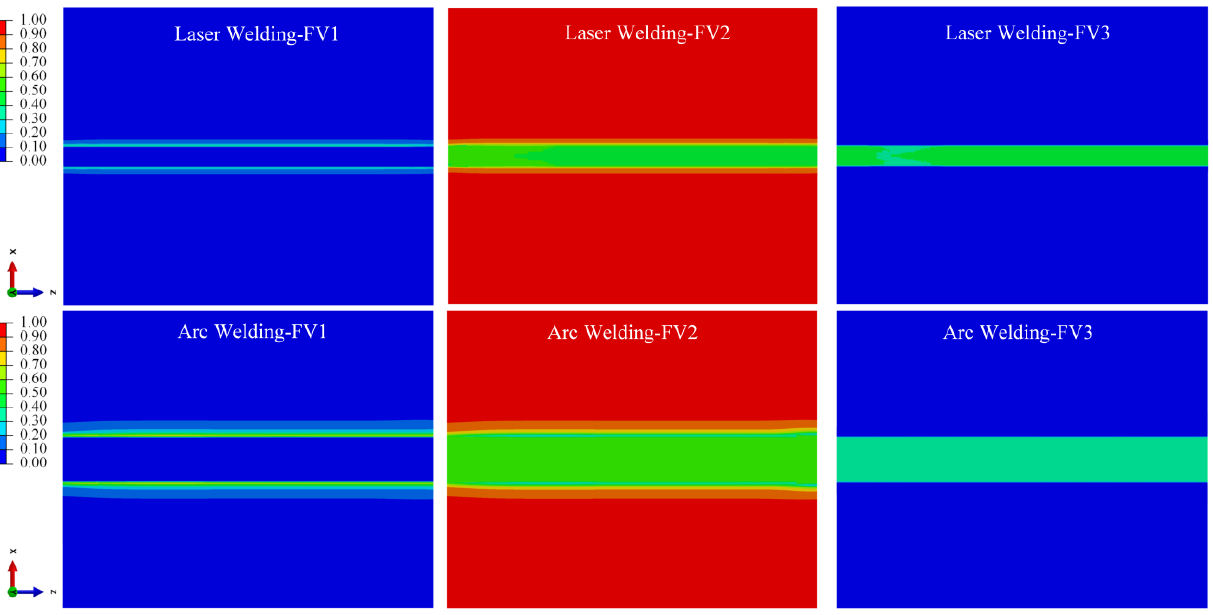
Figure 20. With 60 s from the start time, change of volume fraction of phase composition in weld bead.